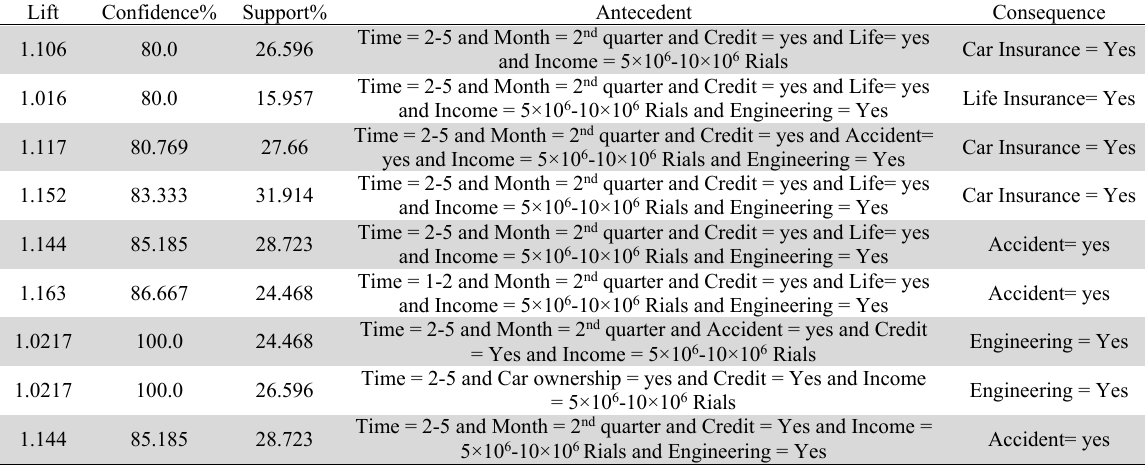
Examples of association rules in